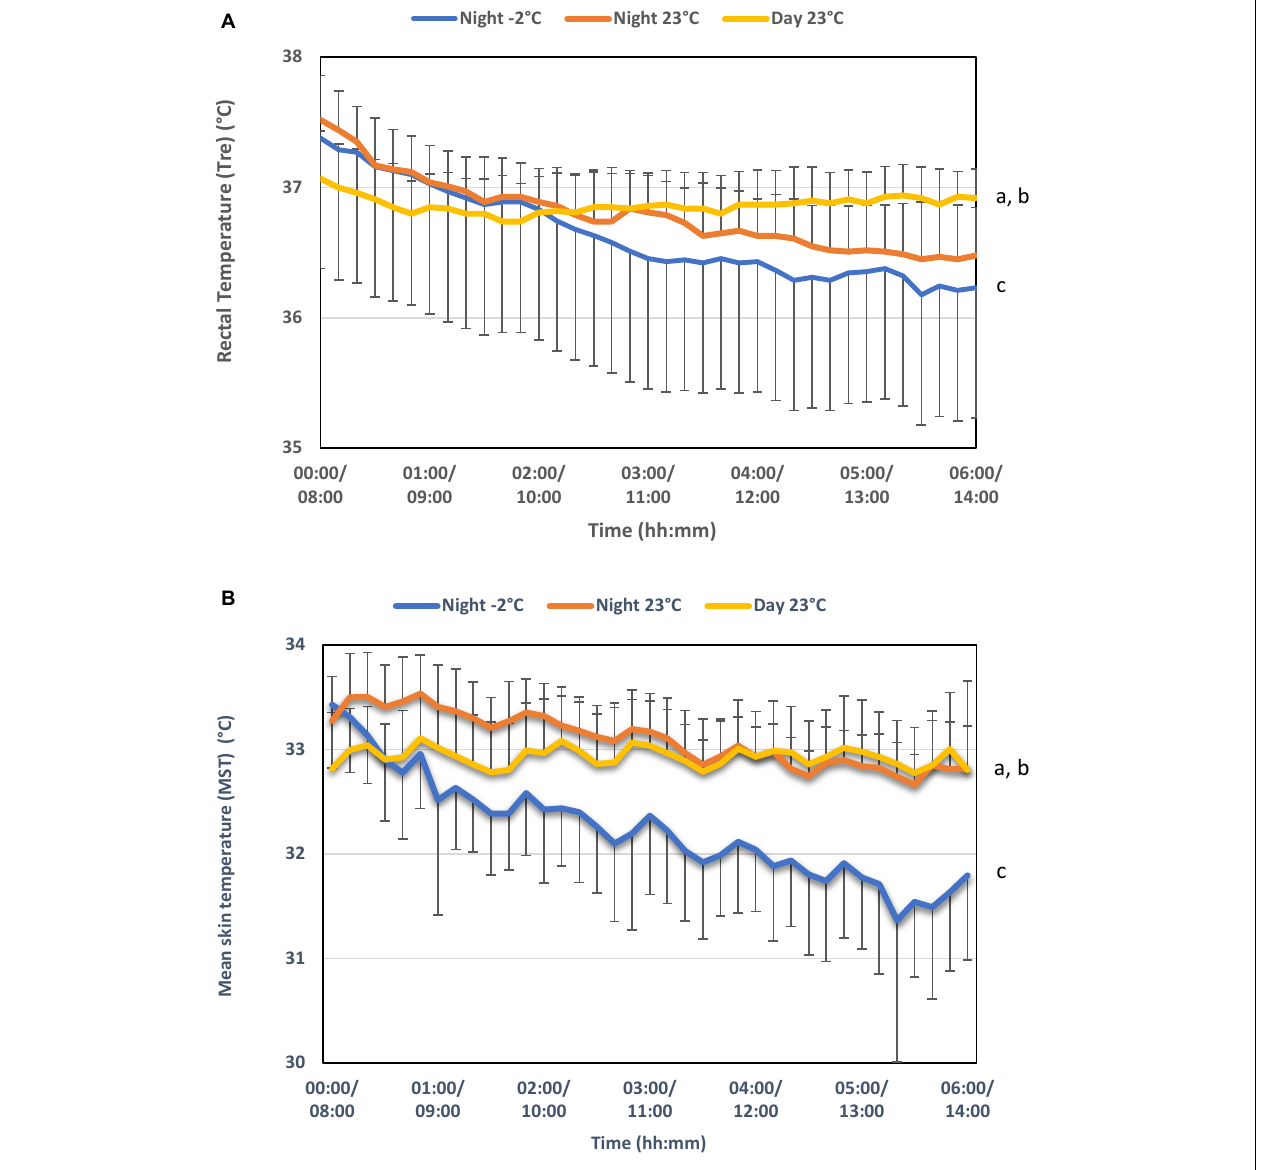
FIGURE 1 | (A) Rectal temperature (T re ) and (B) mean skin temperature (MST) for all exposures. a. A significant difference in the time dependent development of temperature between Night –2 ◦ C and Day 23 ◦ C for T re ( p = 0.001) and MST ( p = 0.001). b. A significant difference in the time dependent development of temperature between Day 23 ◦ C and Night 23 ◦ C for T re ( p = 0.001) and MST ( p = 0.001). c. A significant difference in the time dependent development of temperature between Night –2 ◦ C and Night 23 ◦ C for T re ( p = 0.026) and MST ( p = 0.001). Data are presented as means ± SD ( n = 11 for MST, n = 10 for T re , missing data for one